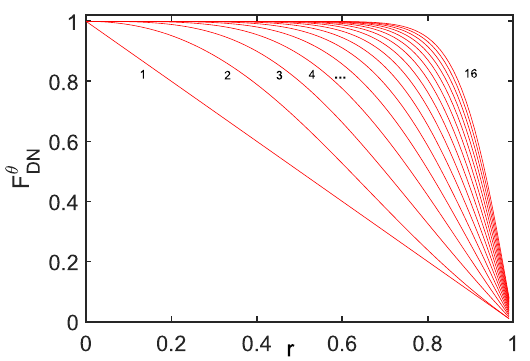
Figure 8. θ F vs. r for GHZ state with θ = π /2 and = … N 1, 2, 3, 4 16 (corresponding to the red full line from DN the left to the right separately as tagged in the figure). It is clear from it that the lager N leads to lager QFI for any r